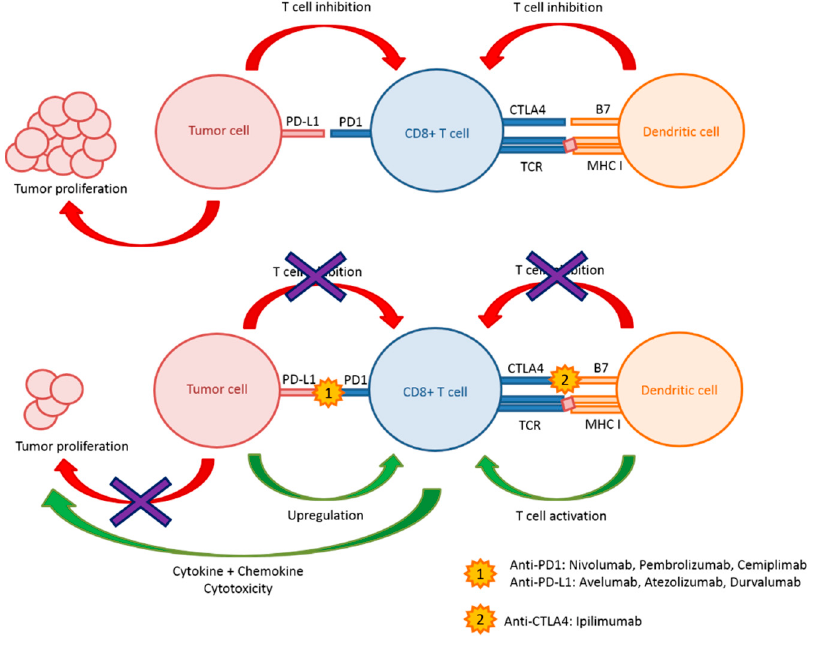
Figure 1. Schematic representation of how immune checkpoint inhibitors work